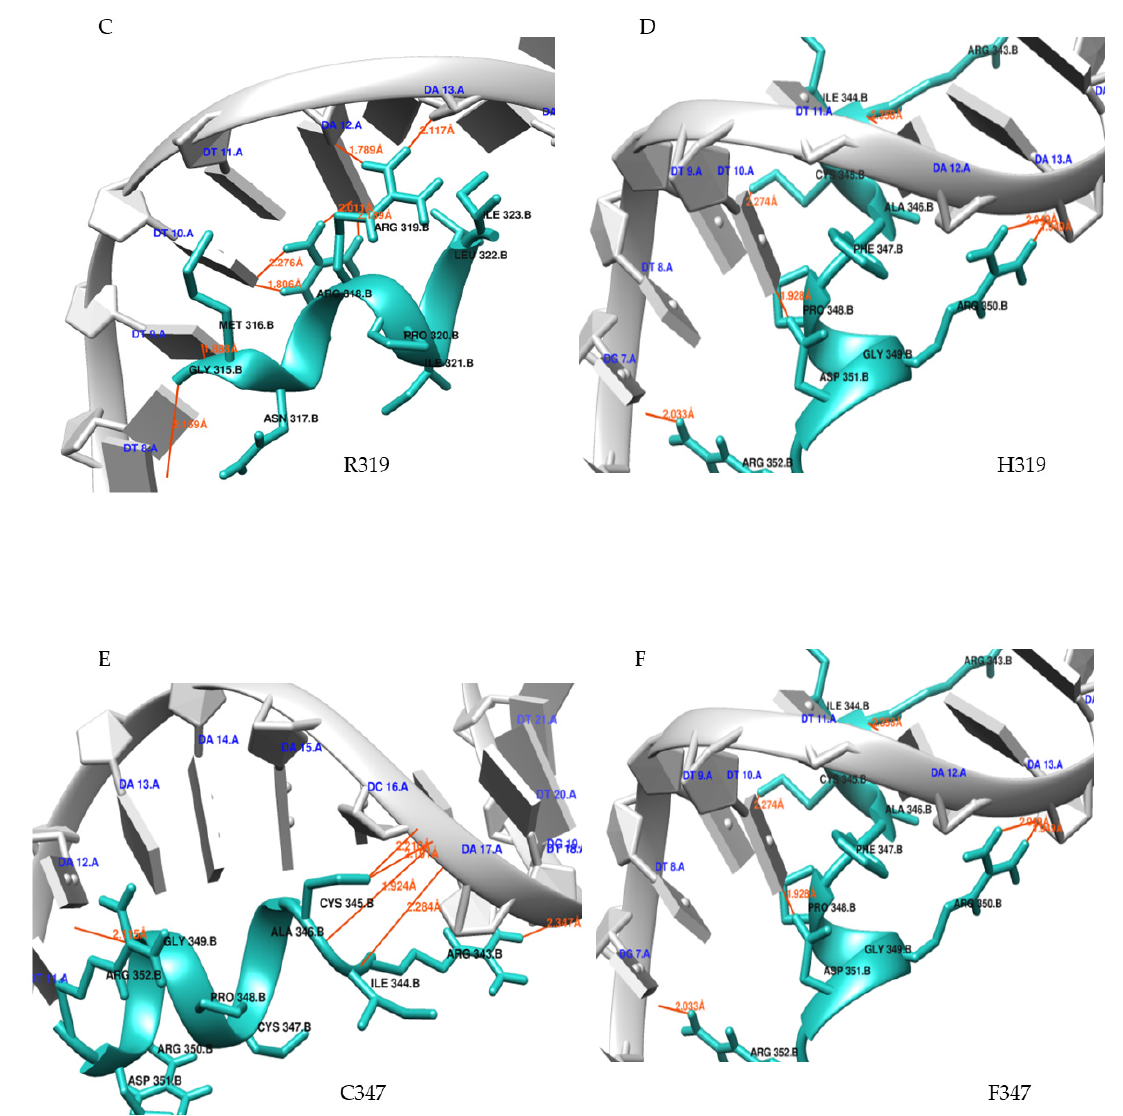
Figure 6. Ligand binding effect of nsSNPs through molecular docking ( A – F ). DNA and native/ mutant TP63 peptide complexes are shown, where DNA is represented by gray and TP63 peptide is denoted by light sea green with red-colored H-bonds. ( A ) Wild-type or native protein (G349) binding with DNA reveals that R352 has three H-bonds with DNA backbone. L353 formed one H-bond each with A12 and A11 of DNA. In addition, C345 and R350 formed one H-bond with DNA backbone and A9 of DNA, respectively. ( B ) Mutated peptide E349 formed only four hydrogen bonds. Due to SNP, E349 lost four hydrogen bonds, accompanied by loss of interaction with DNA. ( C ) Native R319 TP63 peptide generated a total of eight H-bonds. R318 formed two H-bonds each with A10 and A12 of the DNA. Additionally, R319 formed two bonds with A10 and A11 in DNA. ( D ) Mutant H319 formed only four H-bonds, and it is observed that R318 formed two hydrogen bonds with DNA sugar (A13) and H319 formed only one H-bond. This finding correlates with binding affinity reduction in the docking results, as there is a significant number of hydrogen bond loss due to SNP. ( E ) Wild-type or native protein C347 binding with DNA reveals that C345 in peptide has two H-bonds with DNA backbone, A346; I344 formed one H-bond each with DNA backbone, too. R343 and R352 also generated one H-bond each. ( F ) Mutant F347 in TP63 formed a total of six H-bonds. Most of those bonds are different than native residue, and it is observed that R350 formed two H-bonds, whereas it did not form any bond in wild-type. P348 also created bonds with DNA. New bonds are formed but original bonds are lost, which makes the structure less stable and correlates with reduced binding affinity in the docking results. Figures were created in USCF Chimera